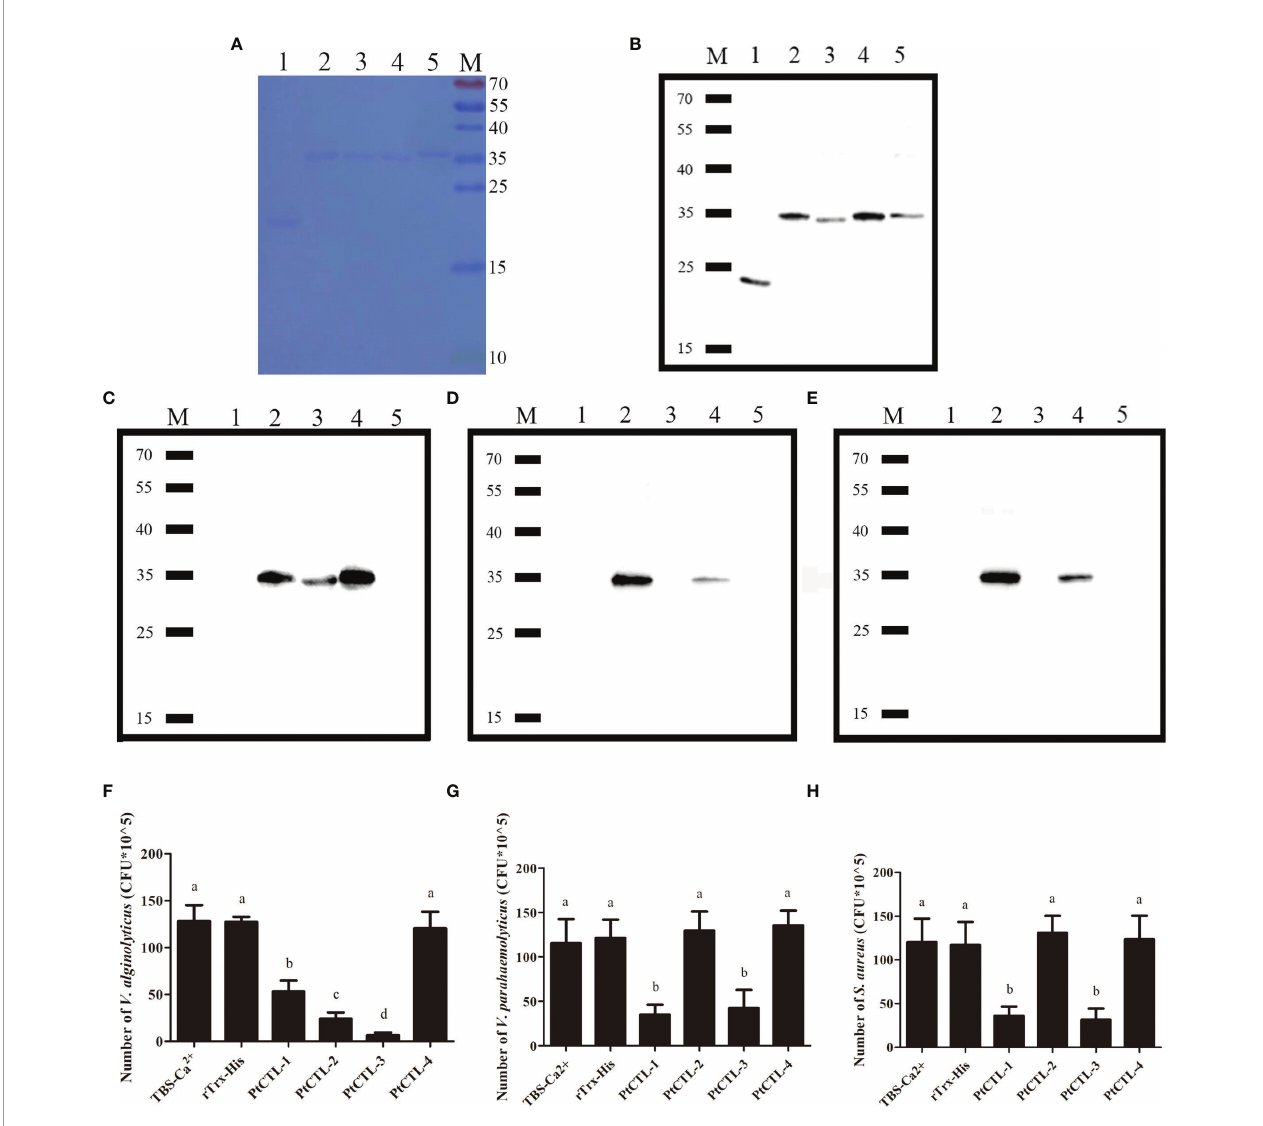
FIGURE 7 | The bacteria binding activity and the antibacterial activities of recombinant CTLs. M, protein molecular standard (kDa); lane 1, rTrx-His; lane 2, PtCTL-1; lane 3, PtCTL-2; lane 4, PtCTL-3; lane 5, PtCTL-4. (A) SDS-PAGE analyses of puri fi ed recombinant proteins. (B) Western blot analyses of puri fi ed recombinant proteins. (C – E) Bacterial binding activity of recombinant PtCTLs proteins against V . alginolyticus (C) , V . parahaemolyticus (D) and S . aureus (E) . (F – H) Antibacterial activity of recombinant PtCTLs proteins against V . alginolyticus (F) , V . parahaemolyticus (G) and S . aureus (H) . Results were analyzed by one-way ANOVA and different letters (a-d) above the bars presented signi fi cant differences between groups at p < 0.05 (n =